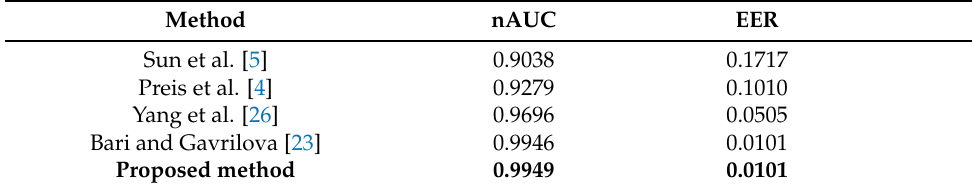
Table 8. nAUC and EER of the proposed method and the prior works on the KGB dataset. The best performance is shown in